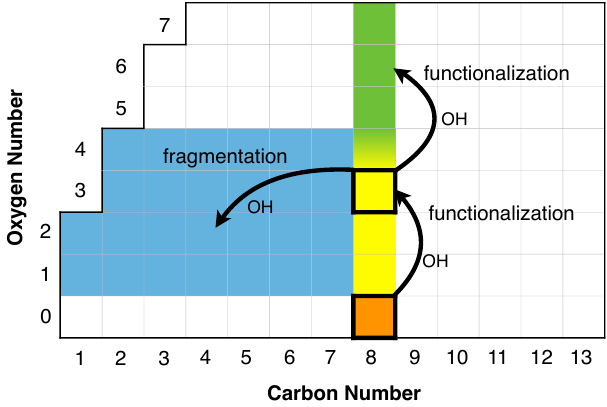
Figure 1. Schematic that demonstrates how the carbon–oxygen grid of the SOM captures the OH-driven multi-generational oxidation of gas-phase organics. Here, a hydrocarbon with eight carbon atoms Figure 1: Schematic that demonstrates how the carbon-oxygen grid of the SOM captures the OH-driven (C 8 H 18 O 0 ; bordered orange cell) reacts with the OH radical and multigenerational oxidation of gas-phase organics. Here, a hydrocarbon with 8 carbon atoms (C 8 H 18 O 0 ; functionalizes to form four products with one, two, three and four bordered orange cell) reacts with the OH radical and functionalizes to form 4 products with 1, 2, 3 and 4 oxygen atoms (yellow cells). One of the products (C 8 H 15 O 3 , bor- oxygen atoms (yellow cells). One of the products (C 8 H 15 O 3 , bordered yellow cell) further functionalizes to dered yellow cell) further functionalizes to form four new products form 4 new products (green cells) or fragments while adding oxygen to form a host of products (blue (green cells) or fragments while adding oxygen to form a host of cells). products (blue